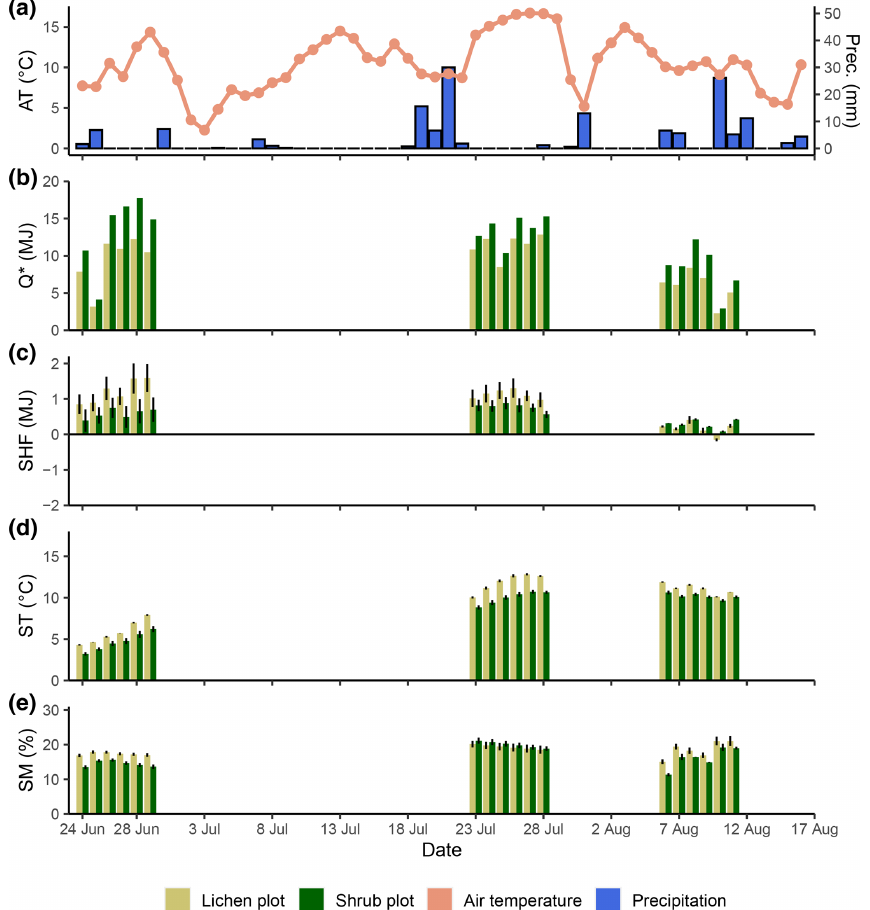
Figure D1. Daily measurements during the field season of 2019 for the background weather conditions (air temperature and precipitation) (a) , net radiation (b) , soil heat flux (c) , soil temperature (d) and soil moisture (e) . Every day is divided into the lichen and corresponding shrub plot for graphs (b) , (c) , (d) and (e) . For ease of display, we calculated averages per plot for the soil heat flux ( n = 2), soil temperature ( n = 3) and soil moisture ( n = 3). Error bars display minimum and maximum values for soil heat flux and standard errors for soil temperature and soil